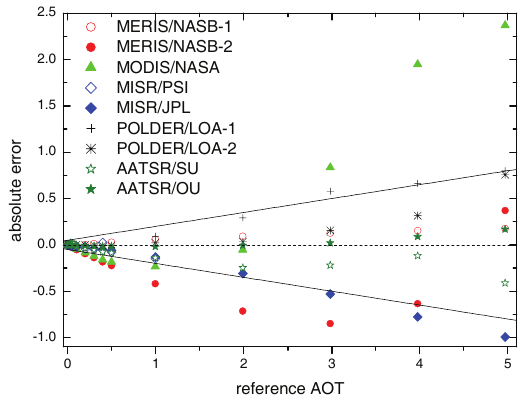
Fig. 11. The absolute errors of retrievals.